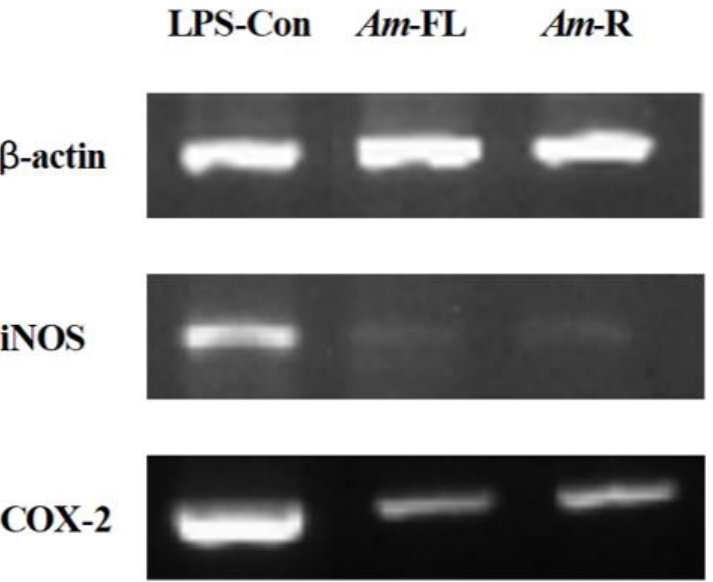
Figure 6. Transcriptional expression levels of iNOS and COX-2 genes in LPS-induced Raw 264.7 cells with underground parts extracts of A. macrocephala . LPS-Con; Control, D-B; Dachul grown under LED-Blue light.